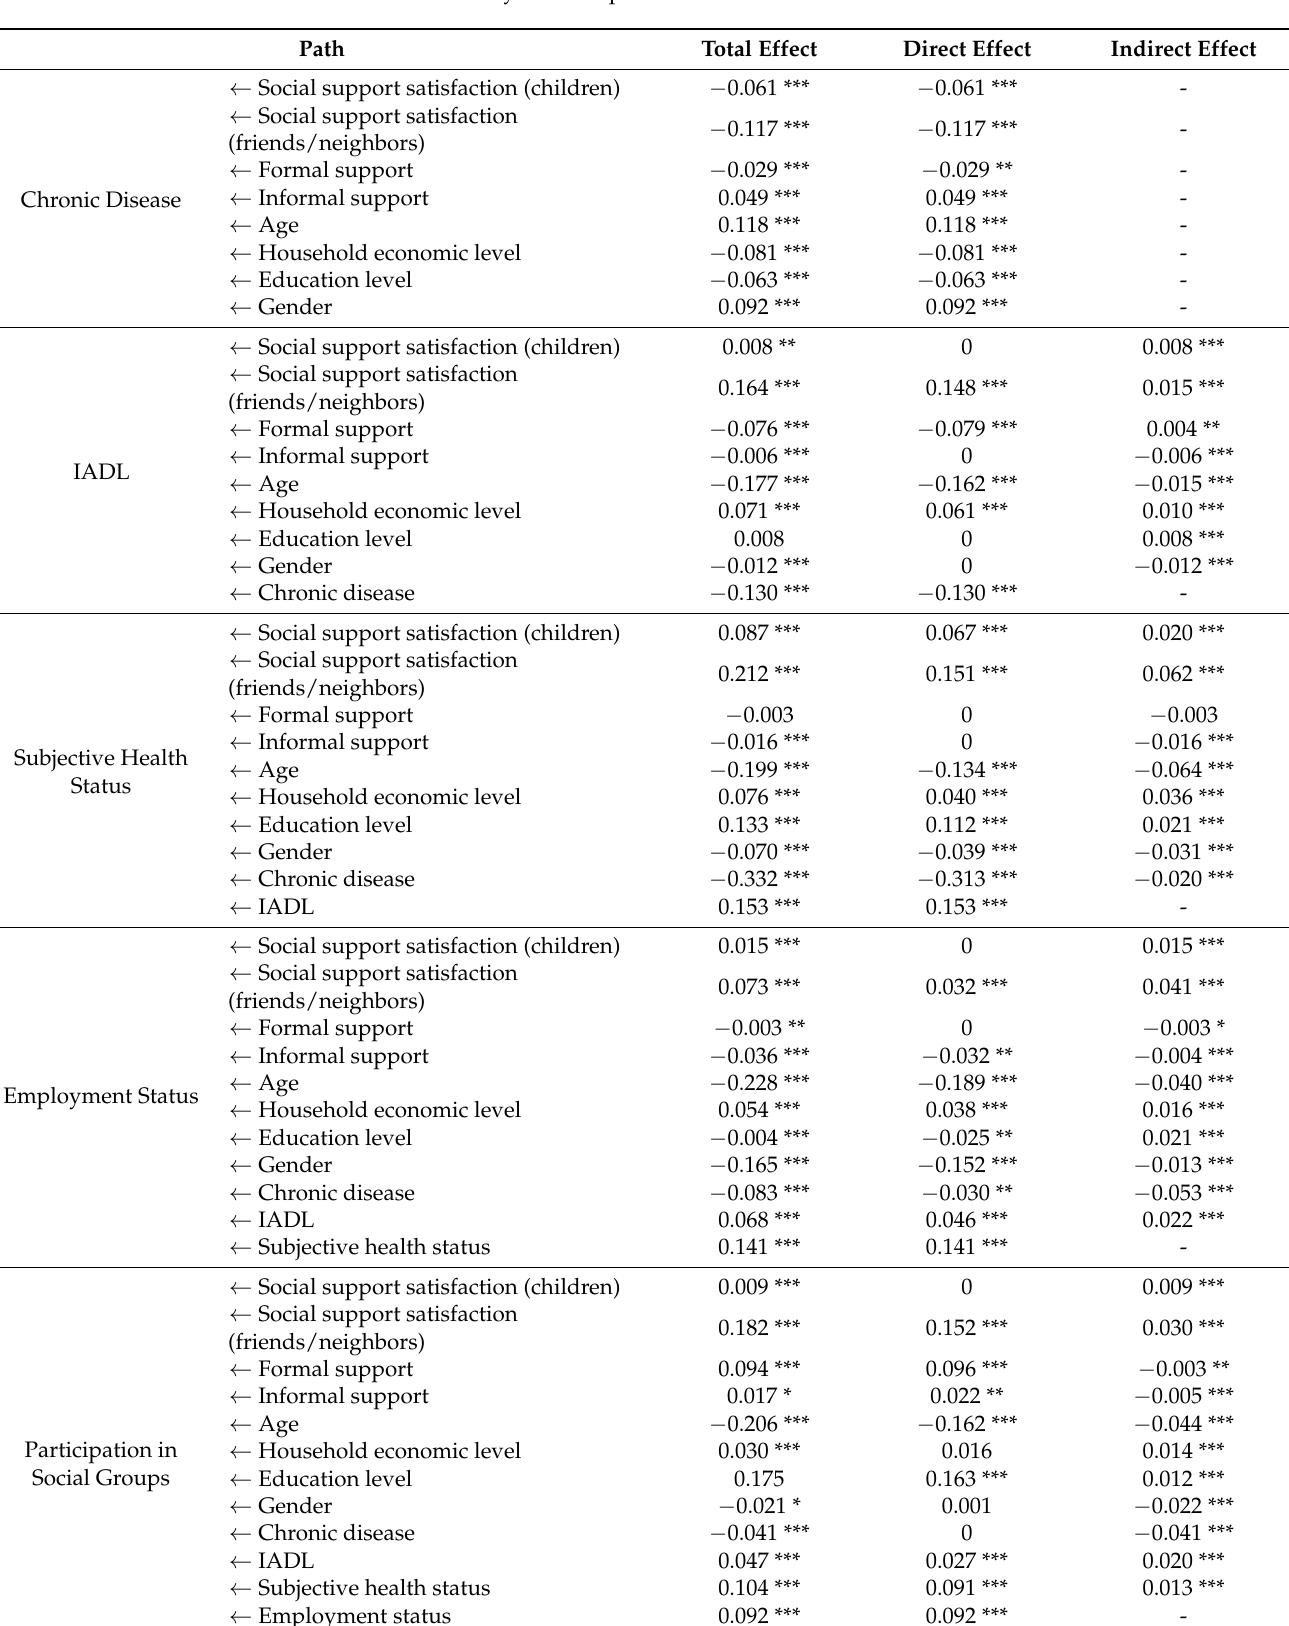
Table 4. Effect analysis of the predictive